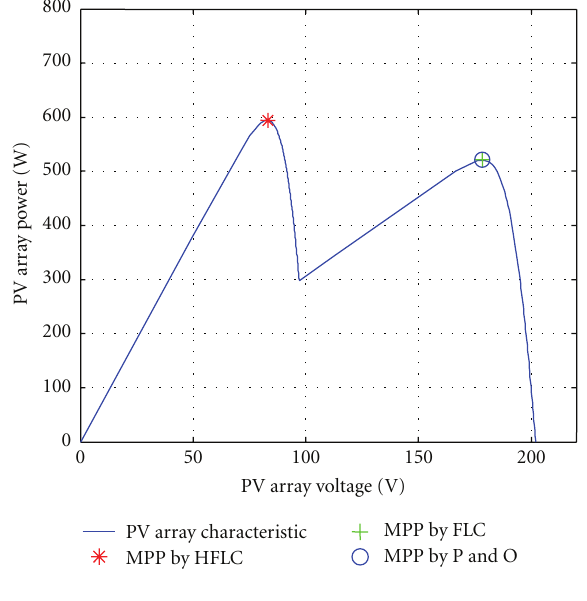
Figure 27: MPP under partial shading 400W/m 2 and 1000 W/m 2 .